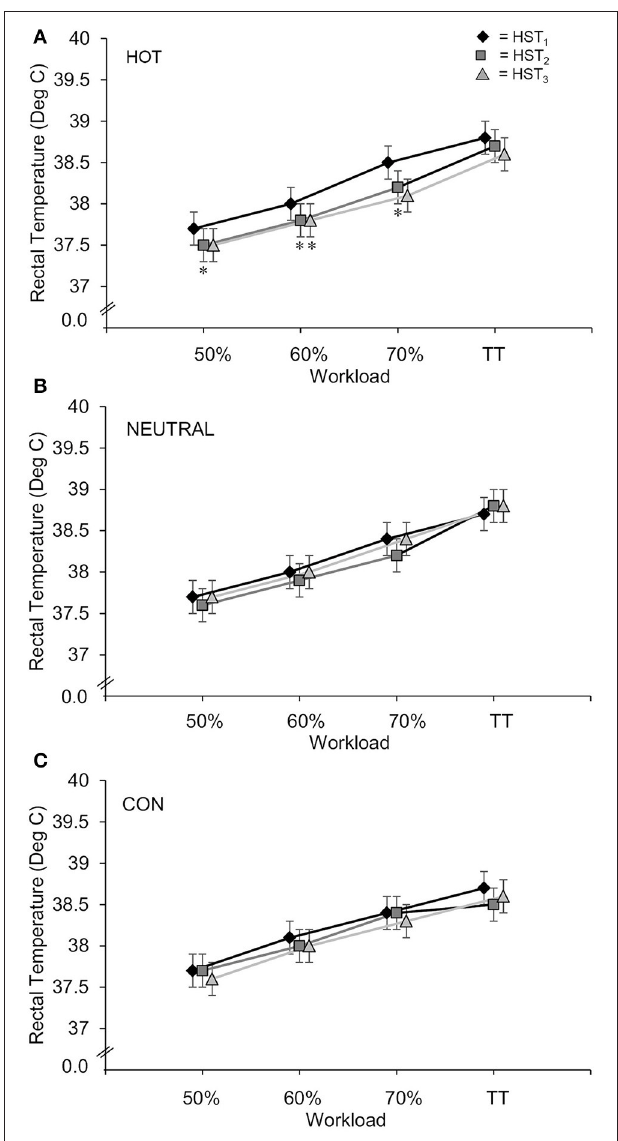
FIGURE 3 | Core temperature for Heat Training (HOT), Thermo-neutral Training (NEUTRAL), and Control (CON) groups during Heat Stress Tests (HST) 1, 2, and 3, expressed as mean ± SD. *Reduced from baseline at HST 2. †Reduced from baseline at HST 3.